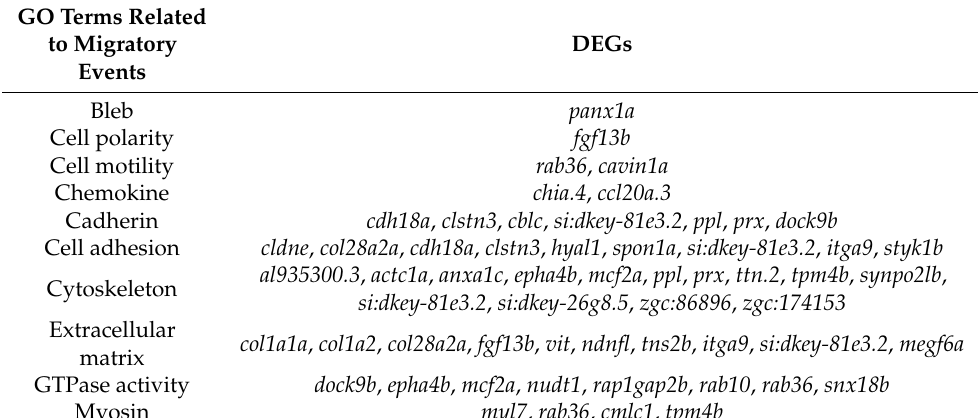
Table 2. The DEGs associated with GO terms of migratory events.